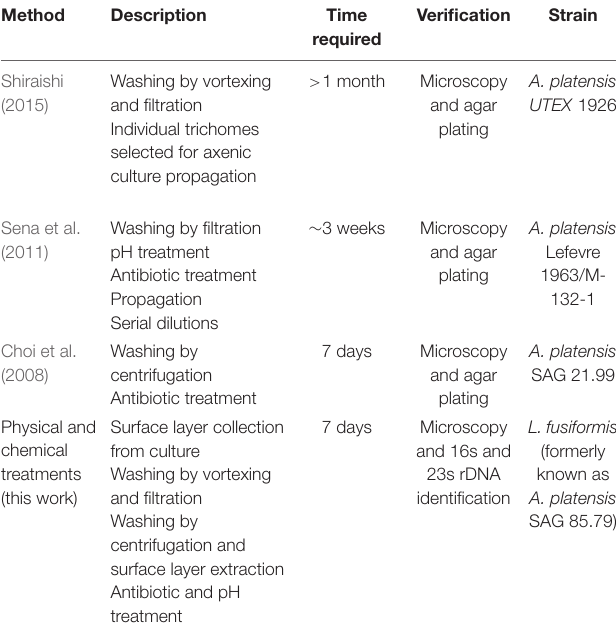
TABLE 4 | “ Arthrospira ” and Limnospira axenicity